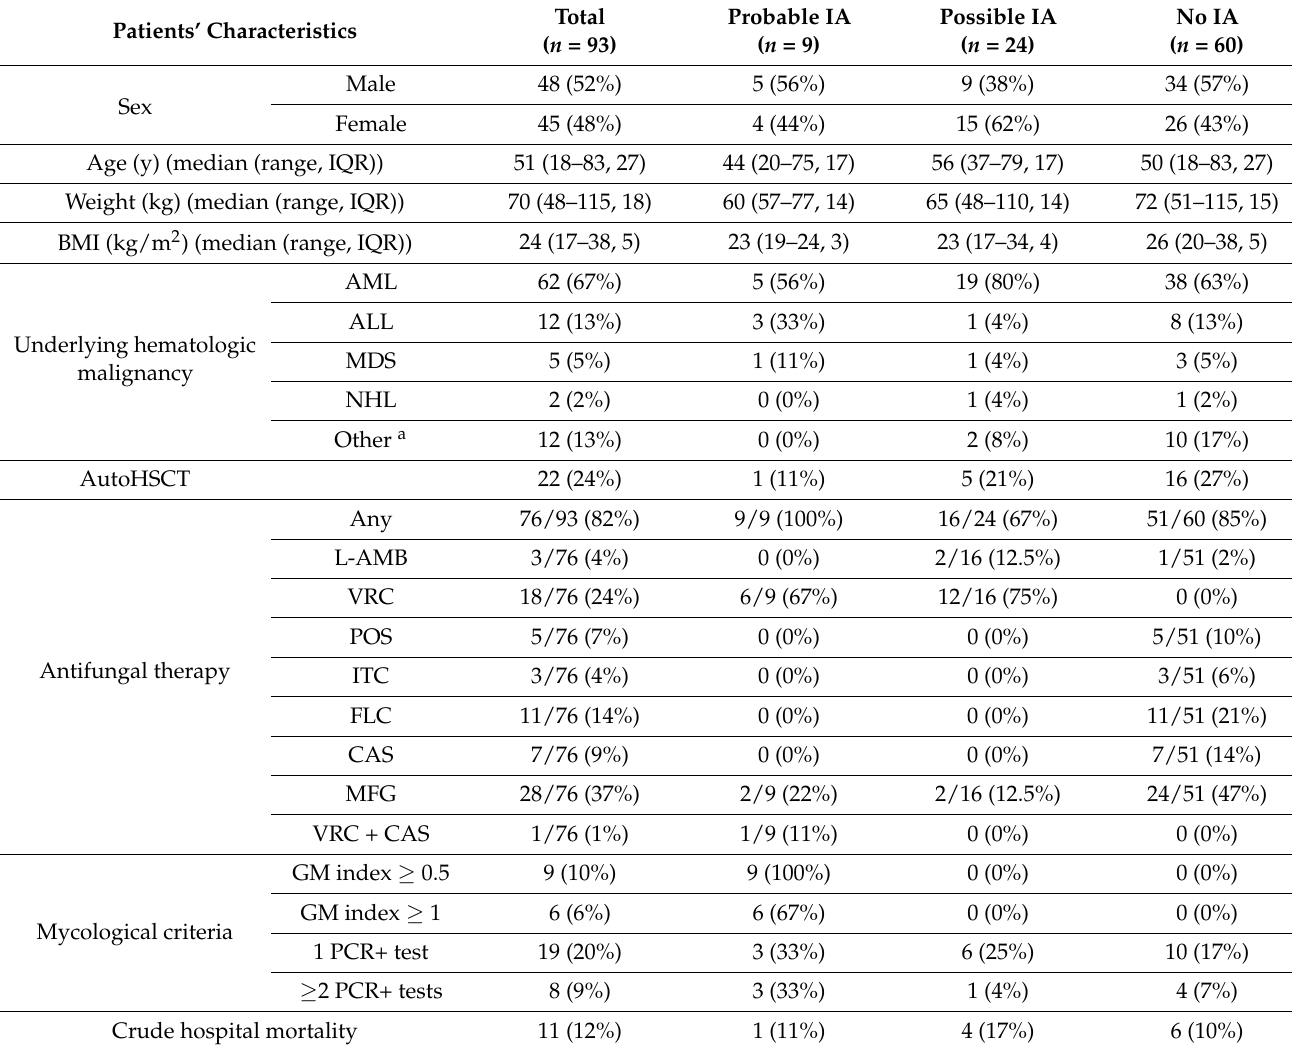
Table 1. Demographic and clinical parameters of the studied cohort. Patient episodes were stratified according to the 2008 EORTC/MSG criteria